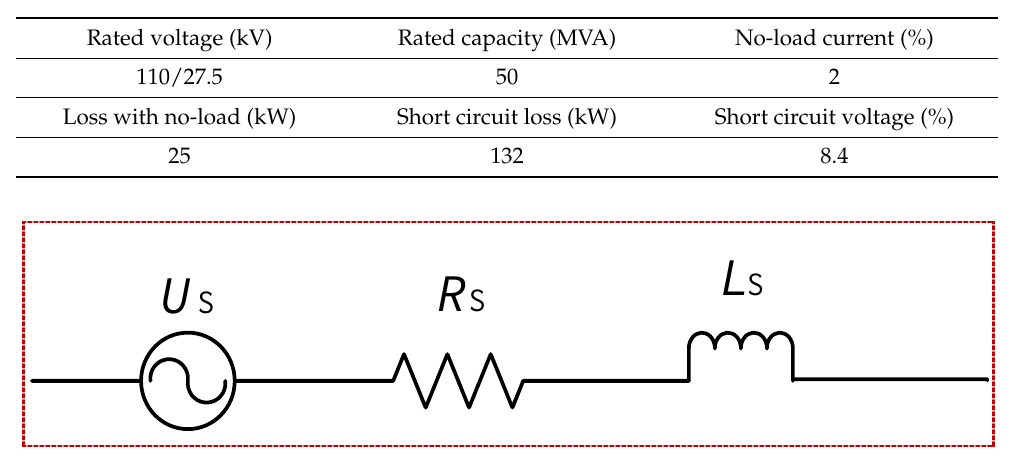
Figure 2. Equivalent model of the traction substation.